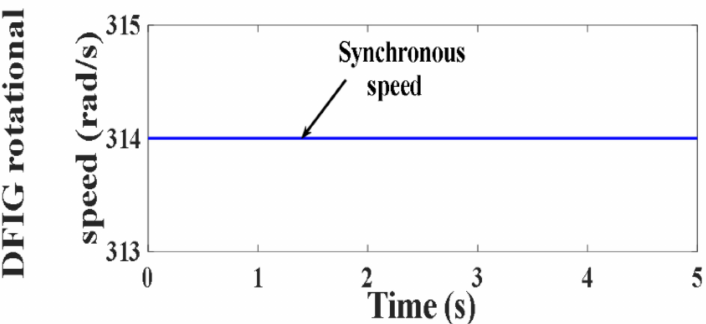
Figure 95. Prime mover operating speeds (rad/s).